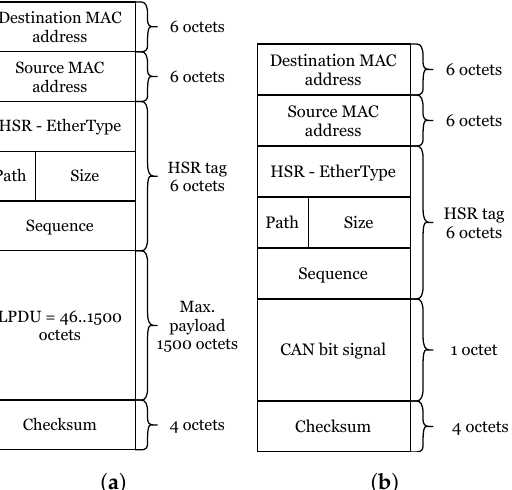
Figure 3. Comparison between a ( a ) standard HSR and ( b ) seamless CAN frame.